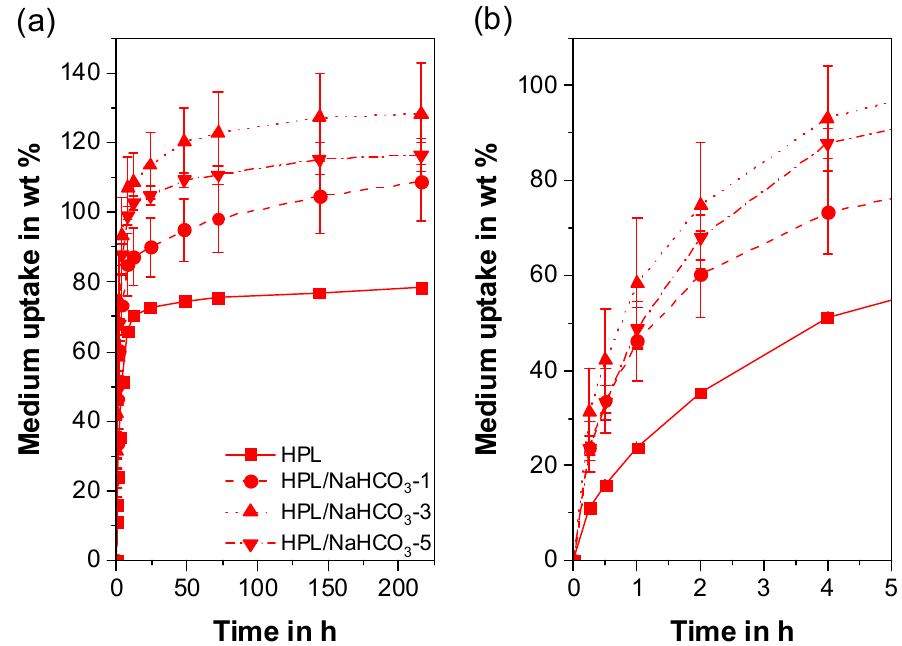
Figure 9. Liquid uptake profiles for formulations comprising hydrophilic thermoplastic polyurethane (HPL) without and with NaHCO 3 ( a ) over a period of 9 days and ( b ) a more precise representation of the first 5 h.